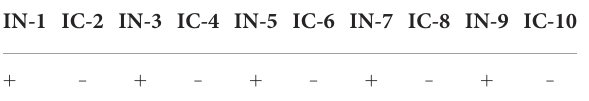
TABLE 1 Schematic of animal allocation. No.